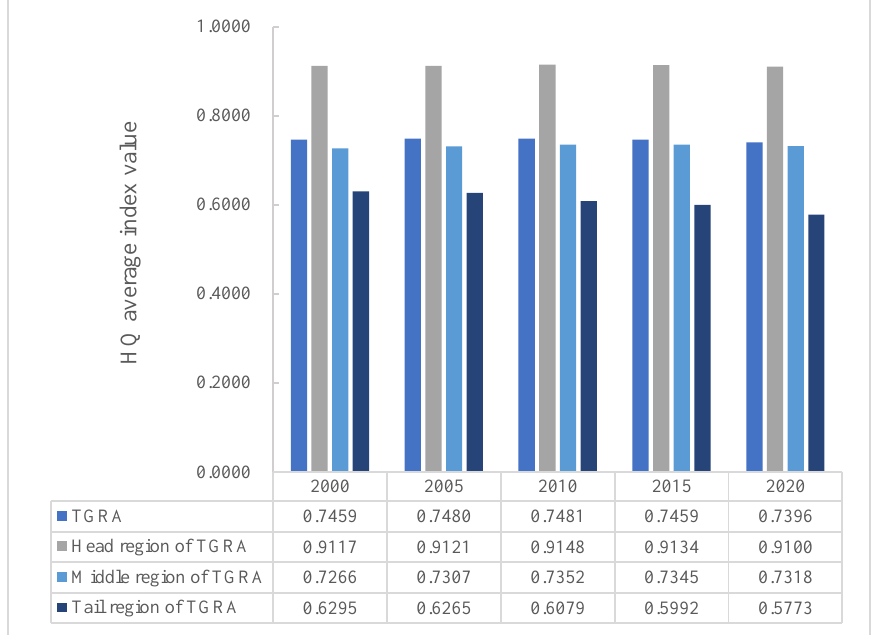
Figure 5. The average value of habitat quality in the TGRA from 2000 to 2020. Table 5. Area and ratio of each HQ level from2000 to